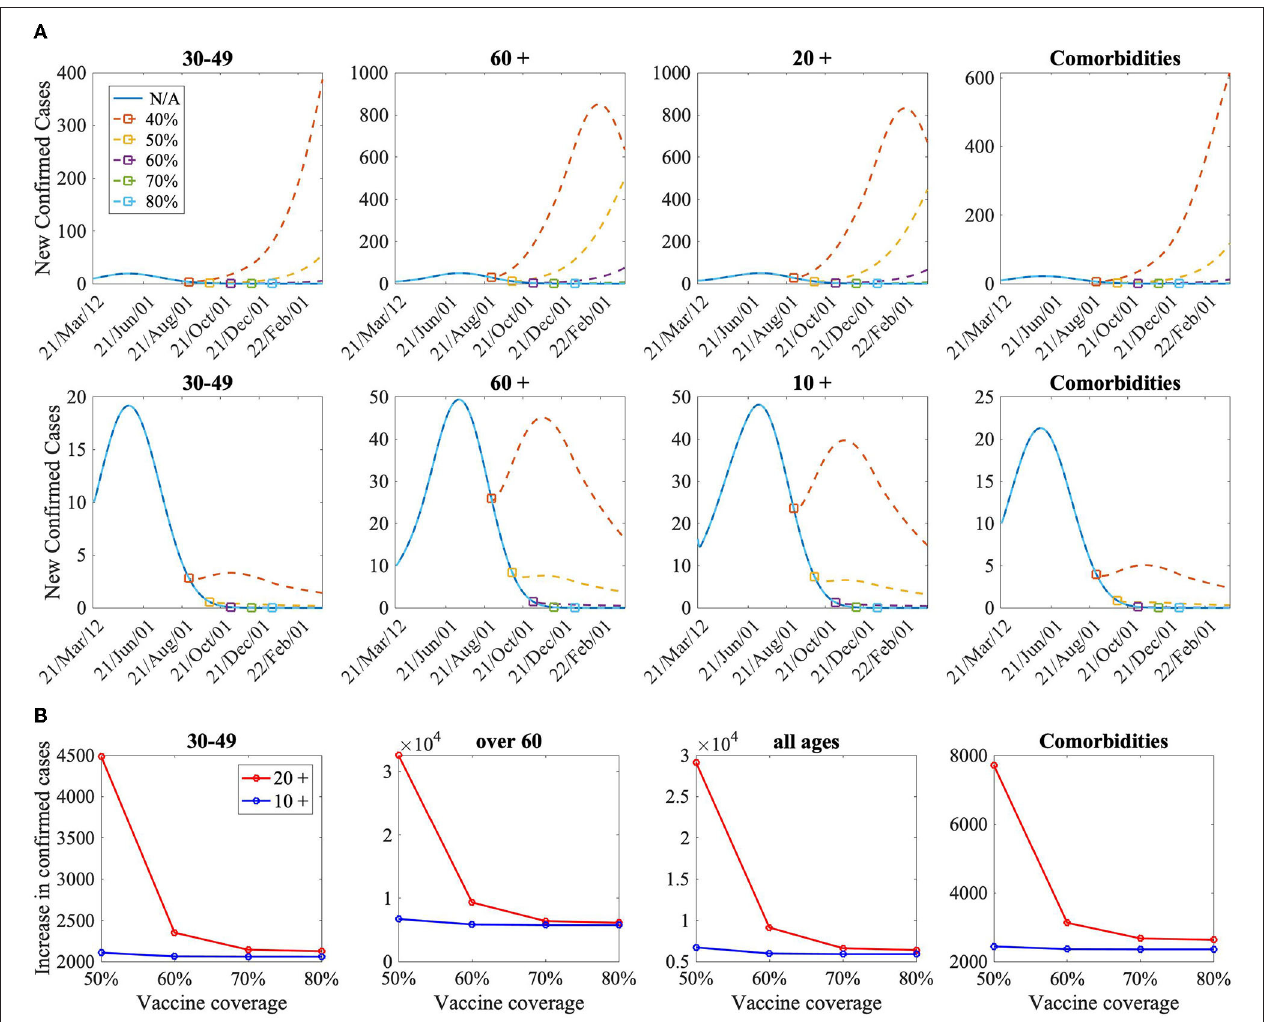
FIGURE 5 | (A) The time series of the number of new confirmed cases according to the reduction of the NPI level for the secondary vaccination rates (50–80%). N/A indicates no mitigation of NPI level for the simulation duration. The top and bottom panels represent the case of vaccination-prioritization strategies for individuals aged 20 years and more and aged 10 years and more, respectively. (B) Comparison of increase of cumulative confirmed cases when vaccination is implemented for aged 20 and older (20 +), and for aged 10 and older